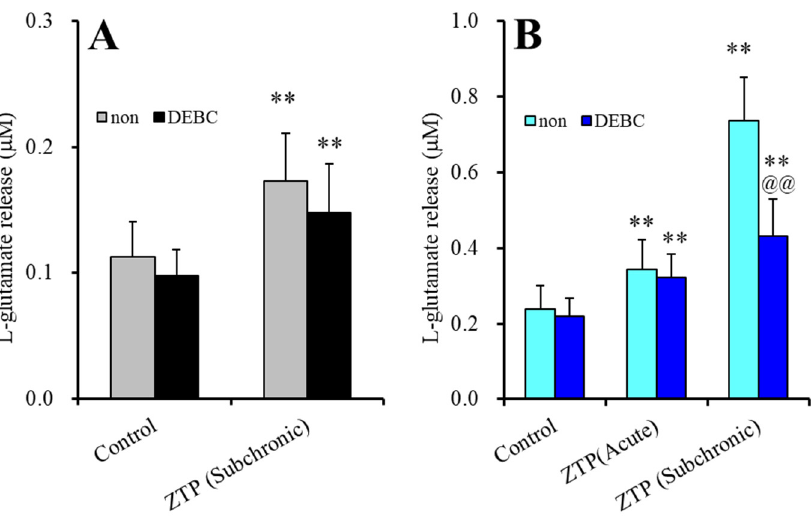
Figure 3. Effects of acute exposure to Akt inhibitor, 10-[4’-(N,N-diethylamino)butyl]-2-chlorophenoxazine hydrochloride (DEBC: 10 µ M) on the stimulatory effects of supratherapeutic concentration of ZTP (1000 nM) on basal ( A ) and HK-ACSF-evoked ( B ) astroglial L-glutamate releases. Light and dark colour columns indicate the incubation without (non) and with DEBC, respectively. * p < 0.05, ** p < 0.01: relative to non, @@ p < 0.01 relative to control by MANOVA with Tukey’s (wholly significant difference) post-hoc test.